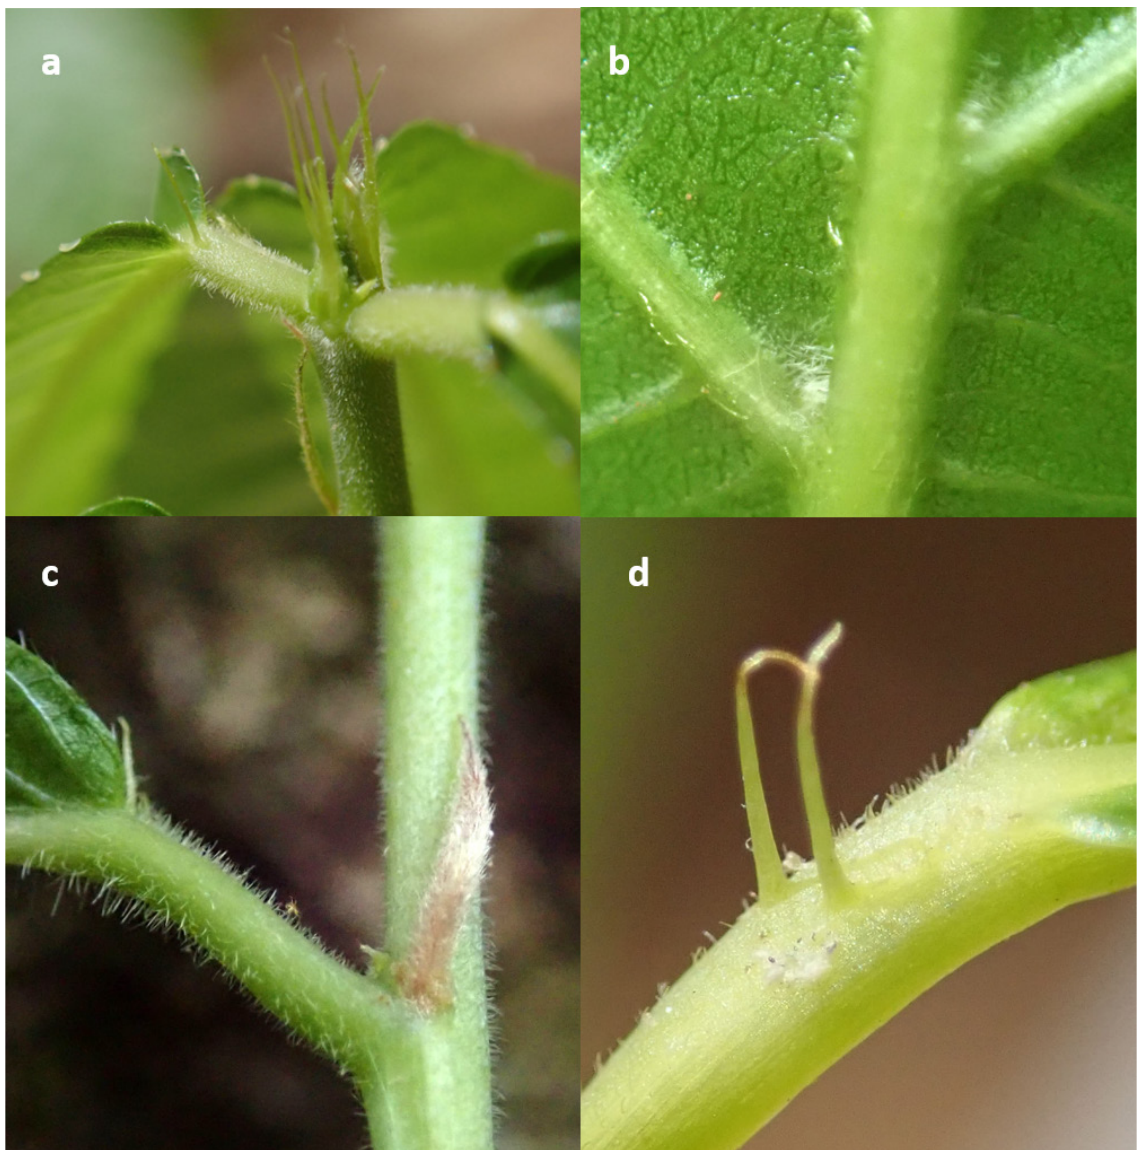
Fig. 5. Field photographs of Paranecepsia andrafiabensis Barberá & O.Lachenaud sp. nov. a .